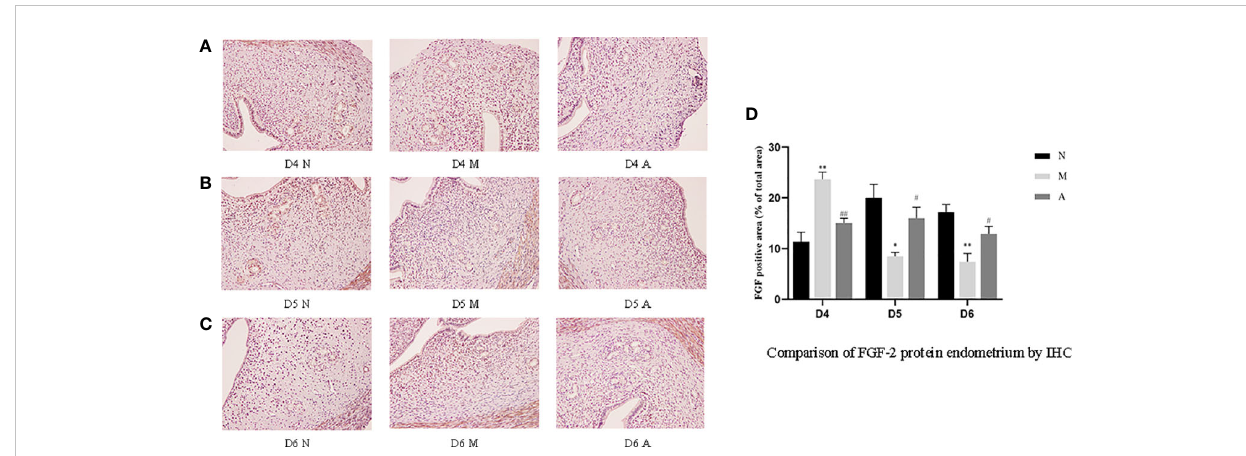
FIGURE 6 The expression of endometrial FGF-2 protein: (A) D4; (B) D5; (C) D6; and (D) comparison of VEGF protein by mean gray value (n=3). *or** represents that there is signi fi cant difference between M and N groups ( P < 0.05 or P < 0.01), #or ## represents that there is signi fi cant difference between A and M groups ( P < 0.05 or P < 0.01). Original magni fi cation *200. FGF-2, Fibroblast growth factor 2; IHC, Immunohistochemistry; D, The embryo day; D4 N, D4 normal group; D4 M, D4 model group; D4 A, D4 acupuncture group; D5 N, D5 normal group; D5 M, D5 model group; D5 A, D5 acupuncture group; D6 N, D6 normal group; D6 M, D6 model group; D6 A, D6 acupuncture group; N, Normal group; M, Model group; A, Acupuncture